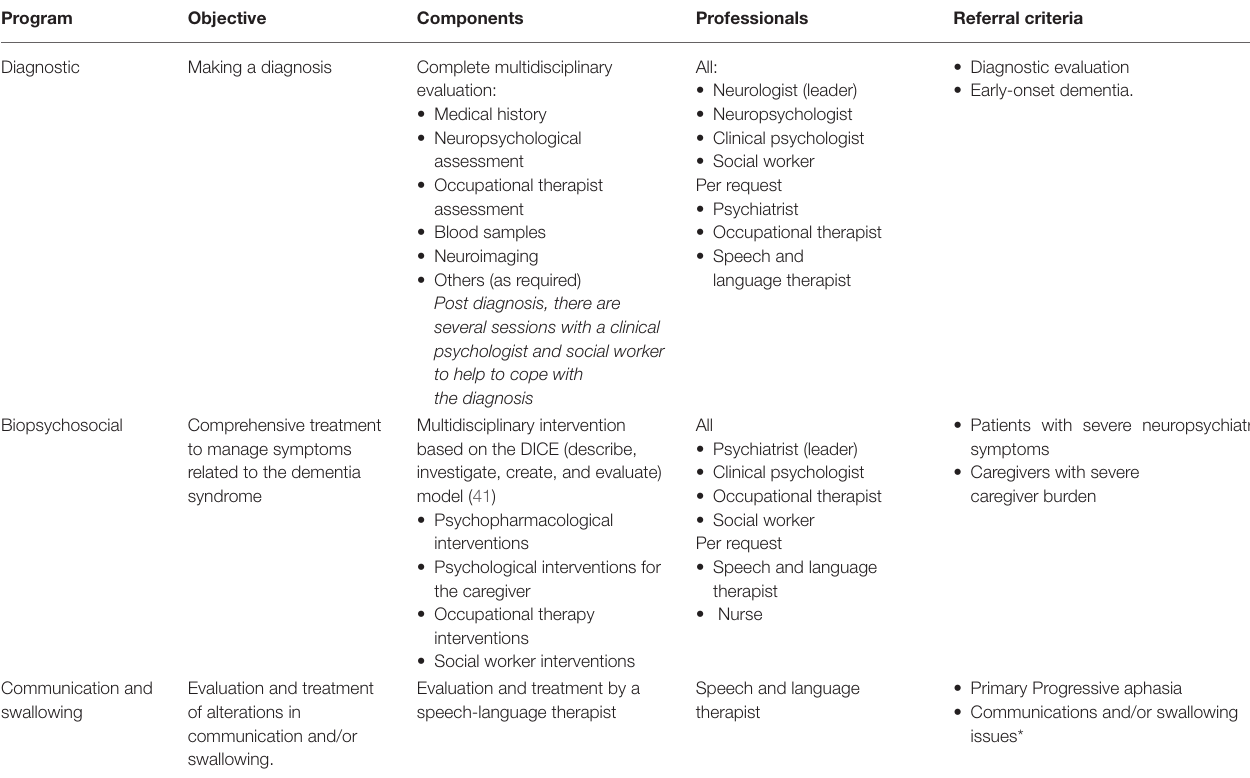
TABLE 2 | Programs of